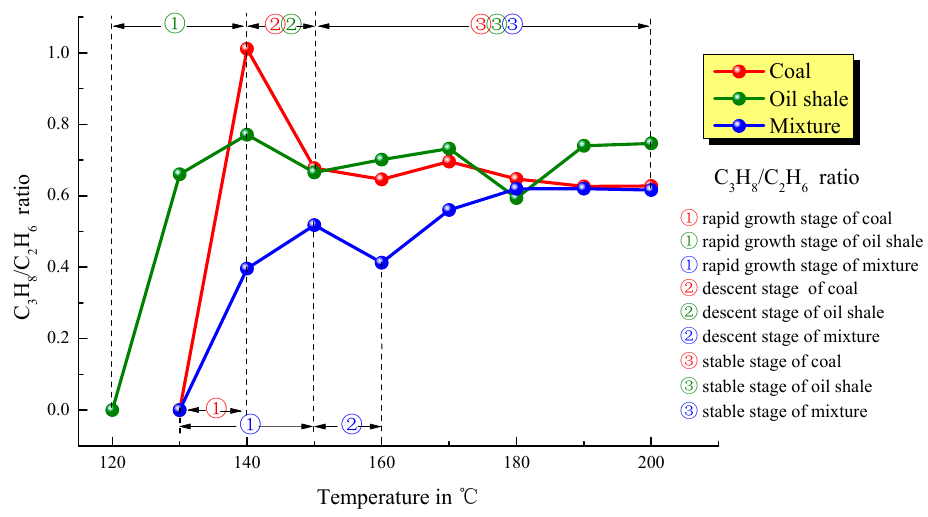
Figure 6. Relationship between the C 3 H 8 /C 2 H 6 ratio and temperature for the experimental samples.